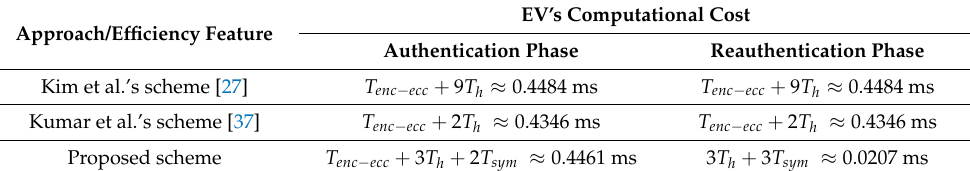
Table 6. Comparison of the computational cost.